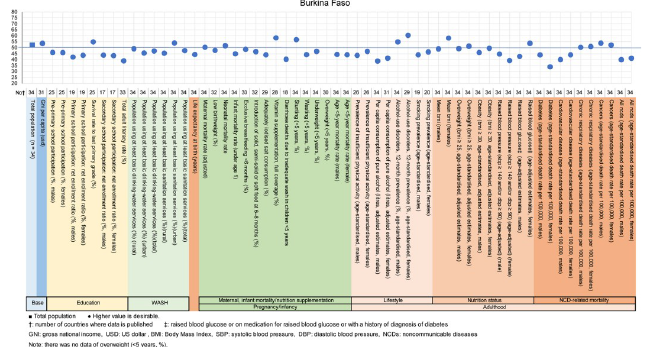
Fig 7. Country diagnosis by the deviation graph for Burkina Faso.